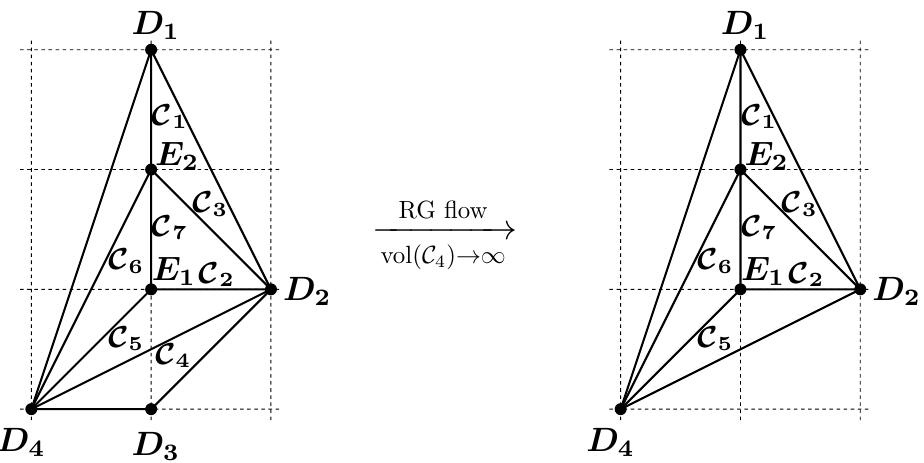
Figure 6 . Decoupling the divisor D 3 leads to the unique crepant resolution of the E 02 ; NL singularity.